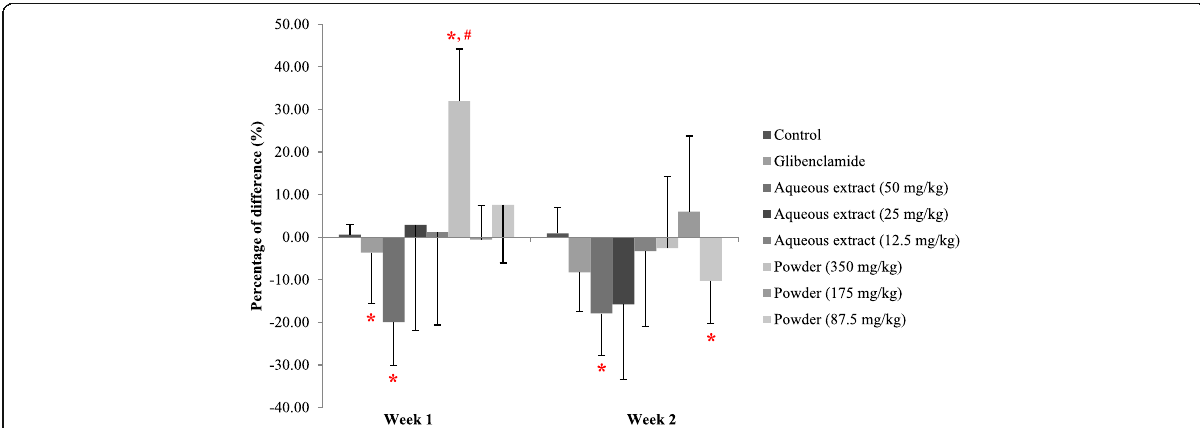
Fig. 2 Effect of herbal formula aqueous extract and powder on 2-h postprandial plasma glucose (2h – PPG) levels of STZ-induced diabetic rats ( N = 5); *Significant different from control group of each week; #Significant different from glibenclamide group of each week ( p < 0.05 ; Mann-Whitney); Data were expressed as mean ±